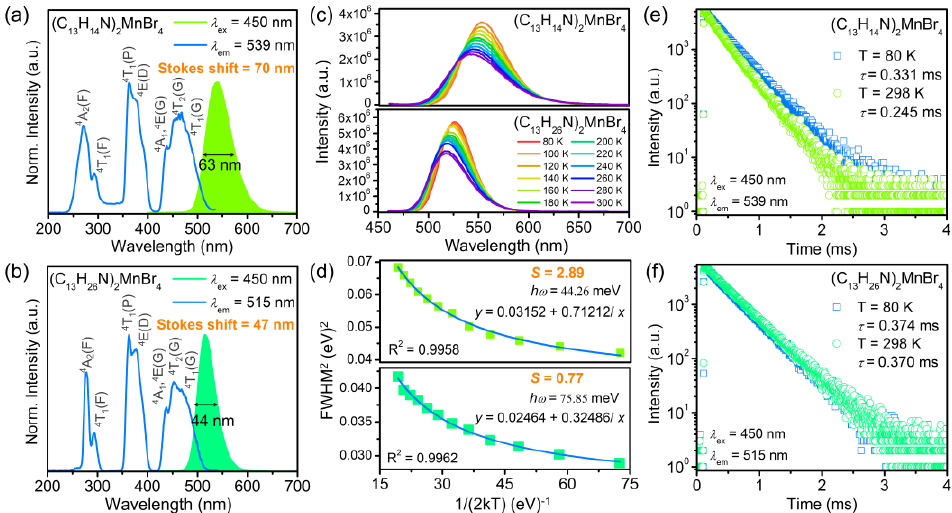
Figure 3. Normalized PLE and PL spectra of ( a ) (C 13 H 14 N) 2 MnBr 4 and ( b ) (C 13 H 26 N) 2 MnBr 4 . ( c ) Tem- perature-dependent PL spectra of (C 13 H 14 N) 2 MnBr 4 and (C 13 H 26 N) 2 MnBr 4 under 450 nm excitation in the range from 80 to 300 K. ( d ) FWHM 2 fitting curves of (C 13 H 14 N) 2 MnBr 4 and (C 13 H 26 N) 2 MnBr 4 as a function of 1/(2kT). Time-resolved PL decay curves of ( e ) (C 13 H 14 N) 2 MnBr 4 and ( f ) (C 13 H 26 N) 2 MnBr 4 at 298 K and 80 K.